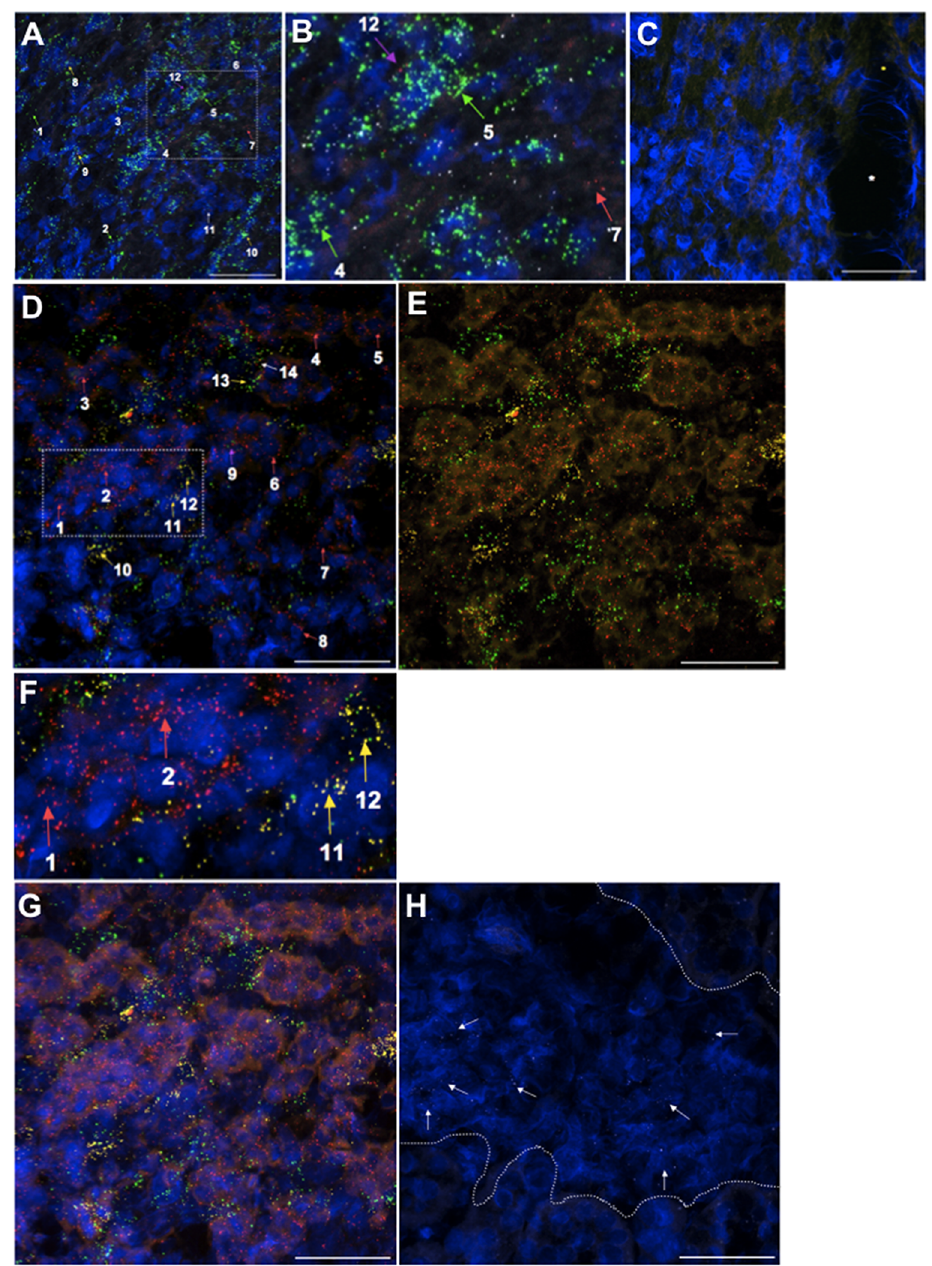
Fig 6. Apela , apelin and aplnr expression in the adult rat heart ventricle and kidney by branched-chain ISHH. The tissues were hybridizedwith RNAscopeprobes and processedin one day. Positive apela , apelin and aplnr and negativecontrol stainingof the heart is shownin ( A, B ) and ( C ), respectively.In ( A ) aplnr - expressingcells (green dots; labelled1–6 with green arrows) are widely distributed in the heart myocardium. The rare cells express only apela (red dots; labelled7 with a red arrow). Some cells are labelledwith both aplnr + apelin (white dots) probes (labelled8–10 with yellow arrows). A few cells express aplnr + apela + apelin (labelled11 with a white arrow) or aplnr + apela (labelled12 with a purplearrow). ( B ) is an enlargement of the dotted area outlinedin ( A ). There was no labellingwith negativecontrol probes in all three channels in the heart ventricles( C ) where * denotesvessel. In the kidney inner medulla( D ) the vast majority of cell expressing apela (red dots; labelled1–8 with red arrows) do not express aplnr (green dots) or apelin (yellow dots). Some cells express both aplnr + apela transcripts (labelled9 with a purplearrow) while aplnr + apelin cells are more common (labelled10–13 with yellow arrows). The rare cell exhibits apela + apelin + aplnr labelling(14; white arrow). Removing the DAPI channelin ( E ) (correspondingimage of ( D )) highlights